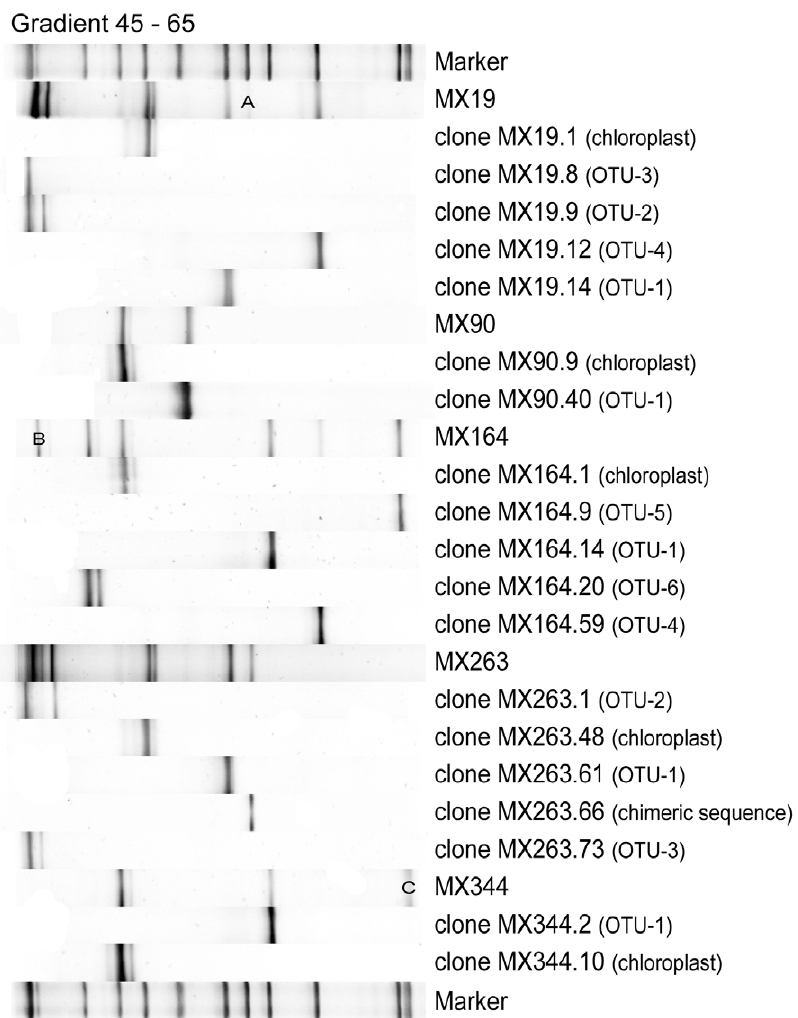
Figure 3. Normalized DGGE profiles of MX DNA extracts and their representative OTUs. DGGE bands marked with letters A, B and C, which did not match any of the individual OTU bands, were excised from the polyacrylamide gel and sequenced. The first and last lanes contain a known molecular marker used for normalization.